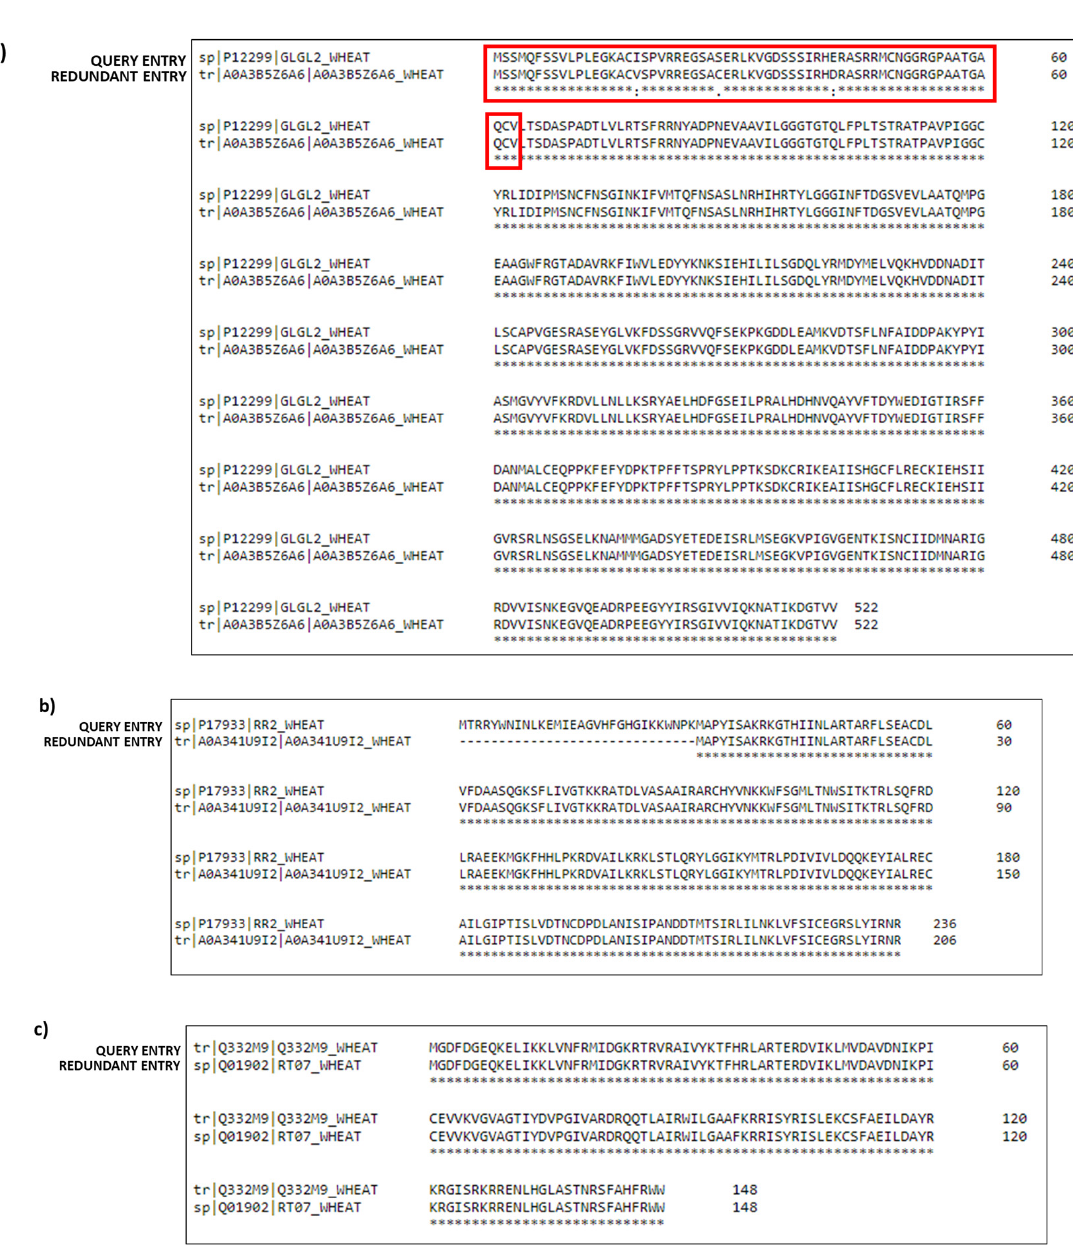
Figure 2. Examples of sequences discarded because of redundancy. For each example, the alignment of the query and the redundant entries is reported. Alignment displays the consensus symbols, which denote the degree of conservation observed in each column. The symbol “*” means that the amino acids in that column are identical in both sequences. The symbol “:” means that conserved substitutions are observed. The symbol “.” means that semi-conserved substitutions are observed.